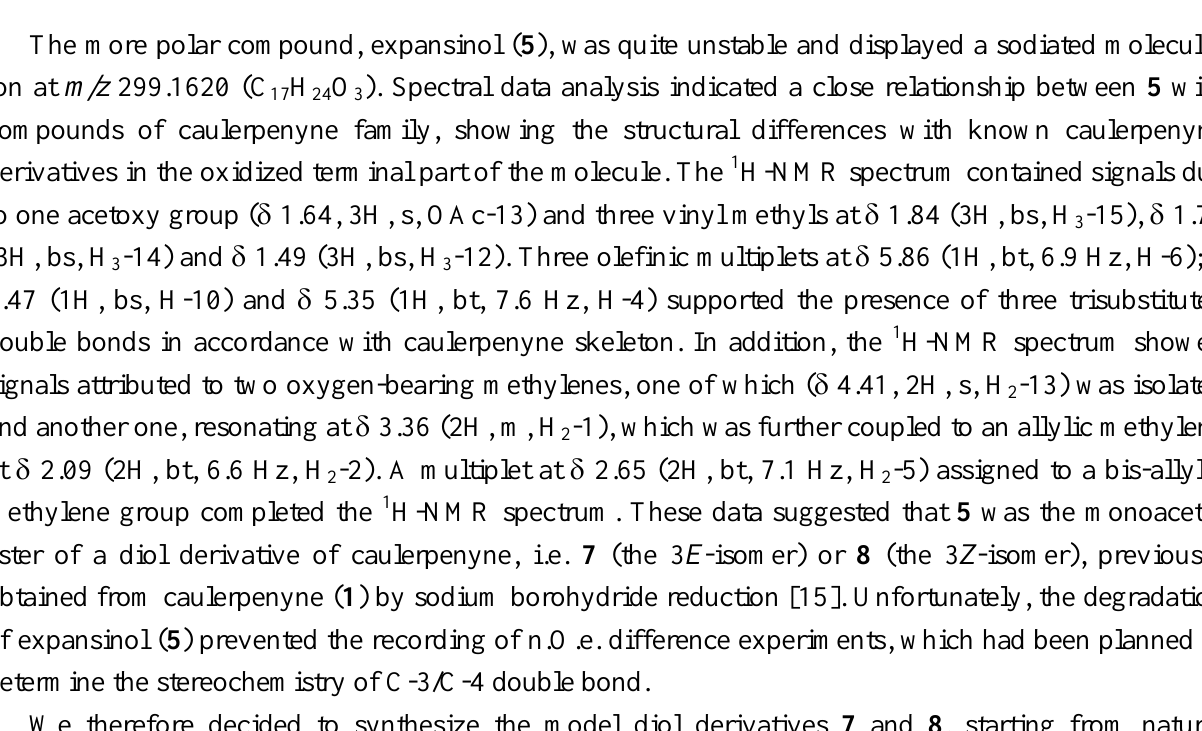
Table 1 NMR Spectroscopic Data a (400 MHz, C caulerpenyne (4 ) and expansinol ( 5 ) , δ C